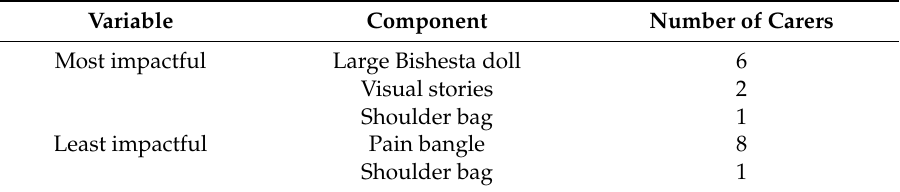
Table 3. Perceived levels of